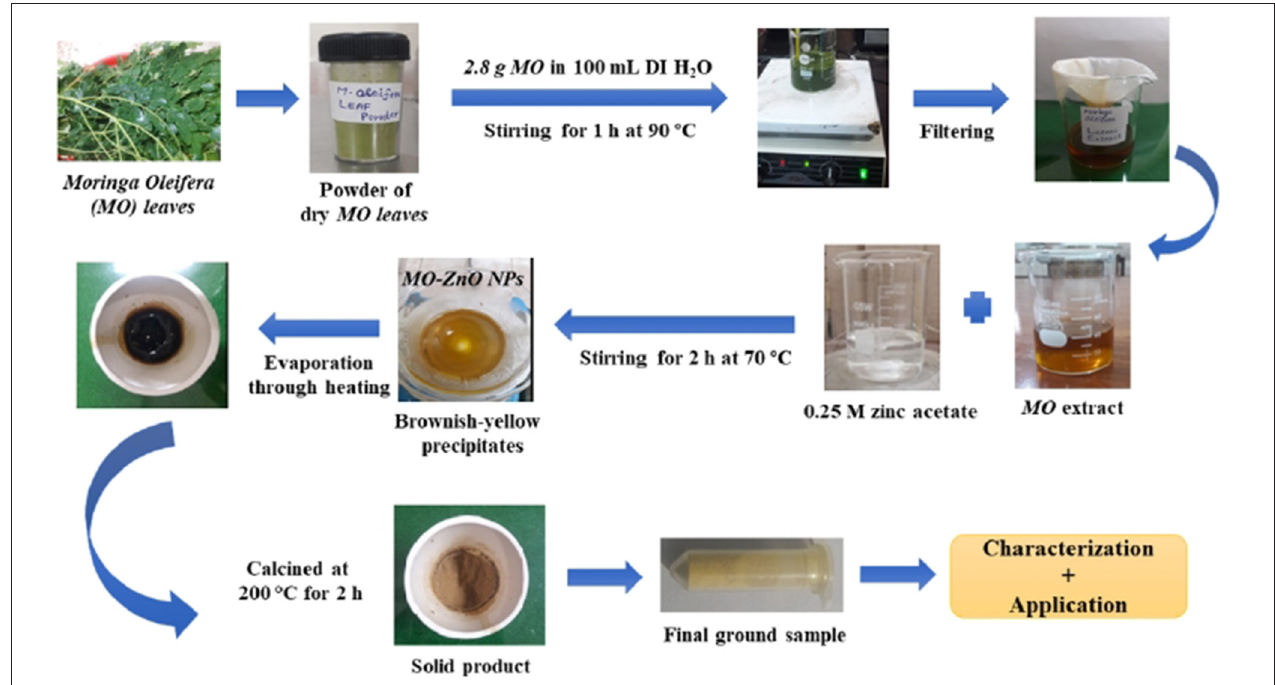
FIGURE 1 | Schematic of the synthesis of Moringa Oleifera ( MO ) leaves-stabilized ZnO NPs.